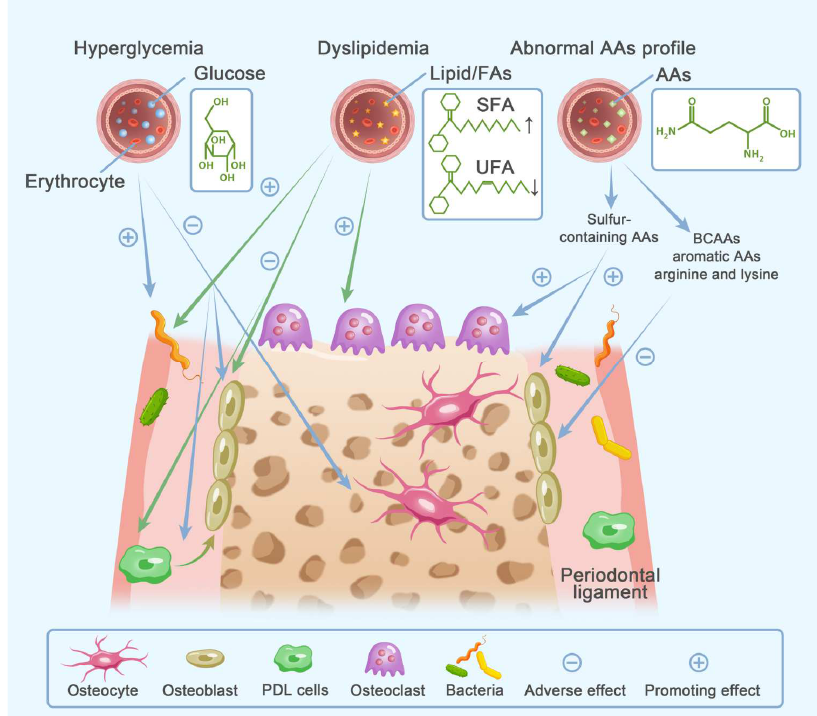
Figure 3. Impacts of metabolic disorders of energy substrates on periodontal status. Hyperglycemia, dyslipidemia and abnormal AAs profile are common manifestations of disordered metabolism of energy substrates. They display comprehensive actions on periodontal components, including PDL cells, osteoblasts, osteoclasts, osteocytes and bacteria. The symbol “+” indicates promoting effect, and symbol “-” indicates adverse effect. FAs, fatty acids; SFA, saturated fatty acid; UFA, unsaturated fatty acids; AAs, amino acids; PDL, periodontal ligament.